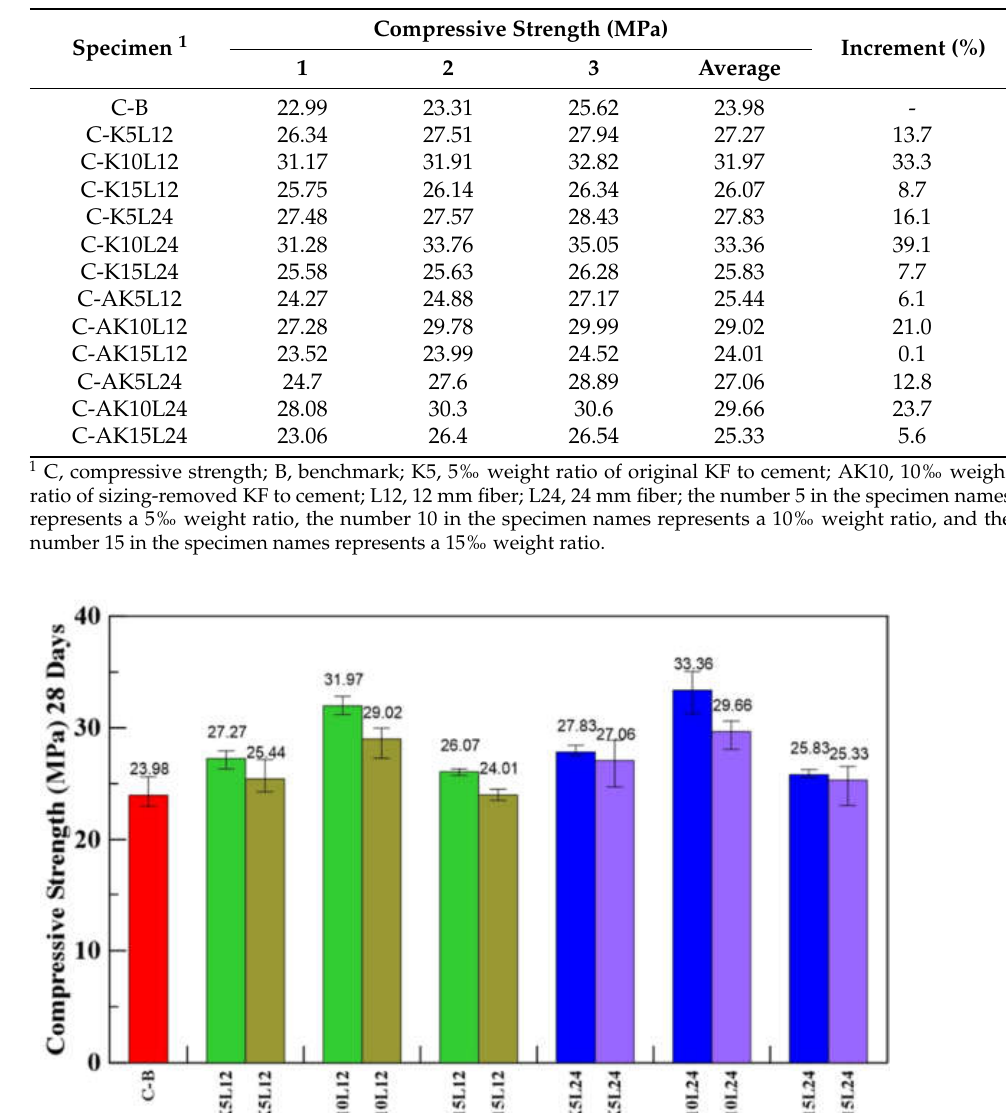
Table 6. Compressive strengths of the benchmark concrete and the KFRC specimens under various weight ratios of KF to cement.